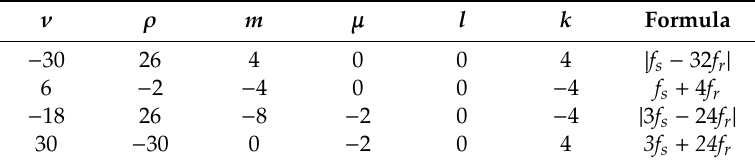
Table 5. Harmonic orders and formulas for the dynamic eccentricity case.